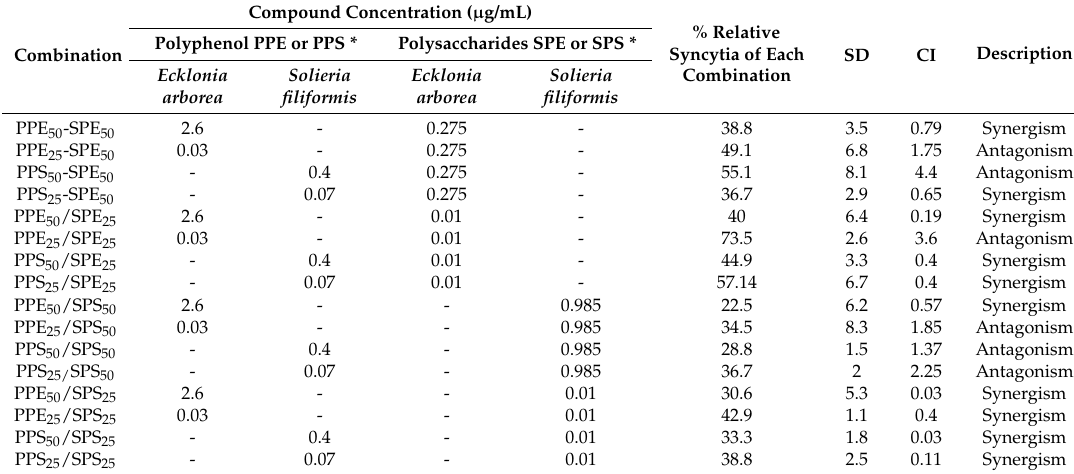
Table 2. Combined antiviral effect of PPs and SPs of Ecklonia arborea and Solieria filiformis.